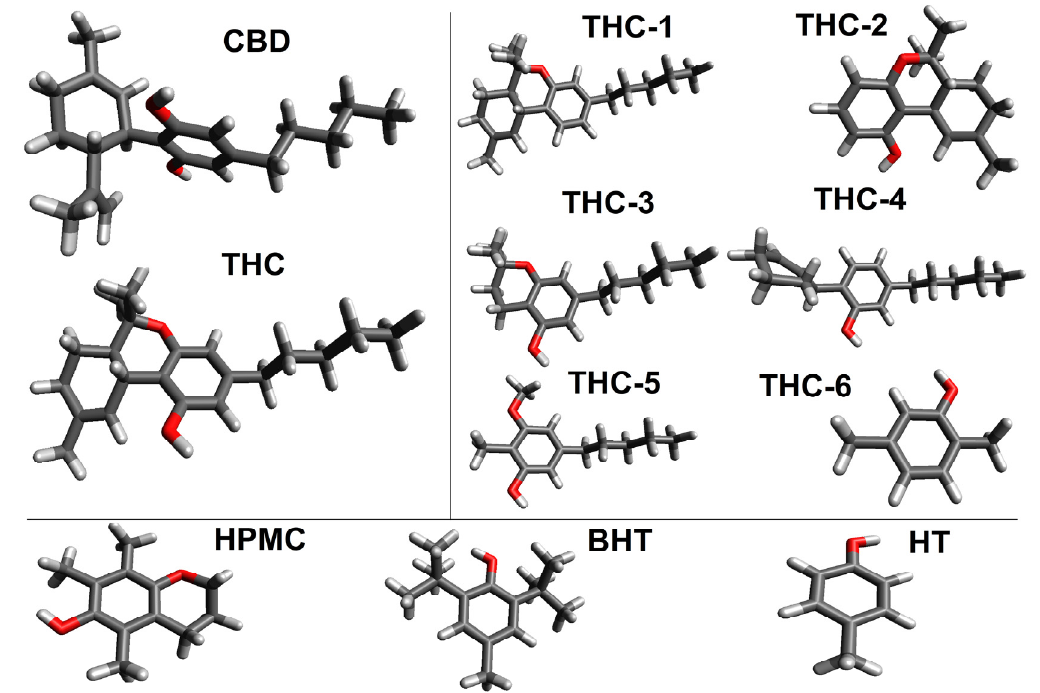
Figure 3. Optimized structures of the neutral